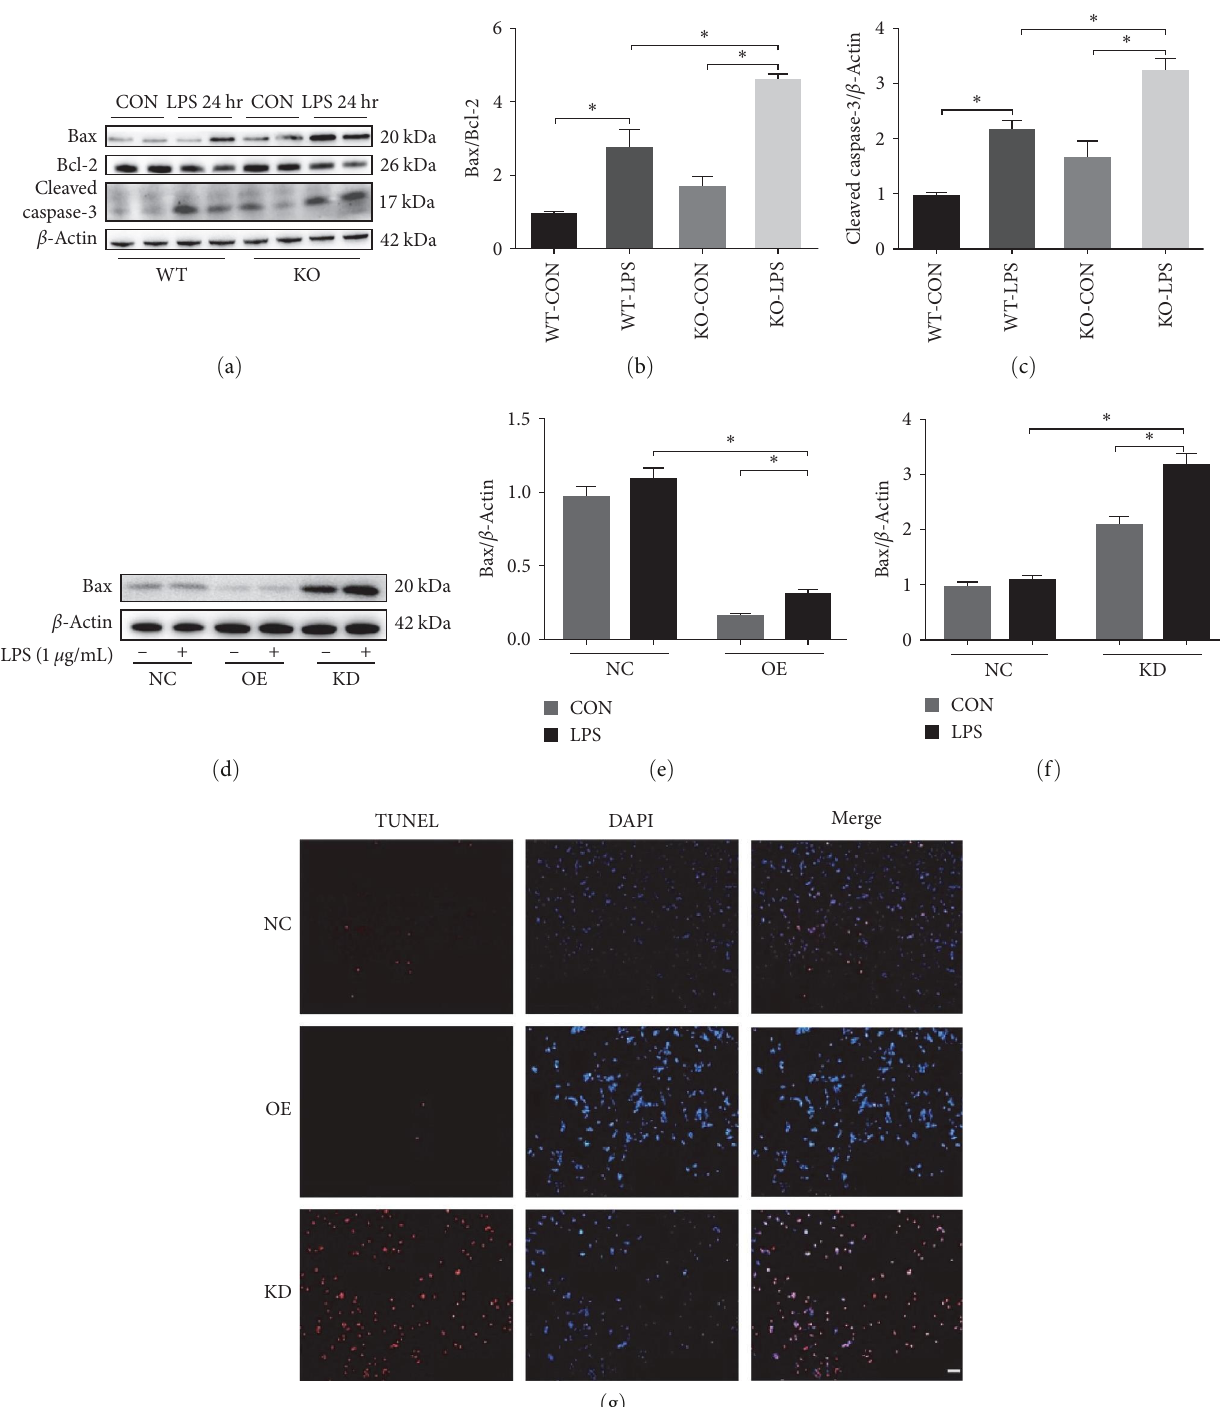
F IGURE 5: Effect of ALDH2 on LPS-induced apoptosis: (a – c) representative western blots and quanti fi cation analysis of Bax, Bcl2, cleaved caspase-3, and β -actin (loading control) in WT and KO mice after LPS administration; (d – f) representative western blots and quanti fi cation analysis of Bax and β -actin (loading control) in OE, KD, and NC cells after LPS challenging; (g) representative images of TUNEL assay in OE, KD, and NC cells after LPS challenging. Scale bars: 50 μ m. All data are expressed as mean Æ SEM ( n = 6). ∗ P < 0 :